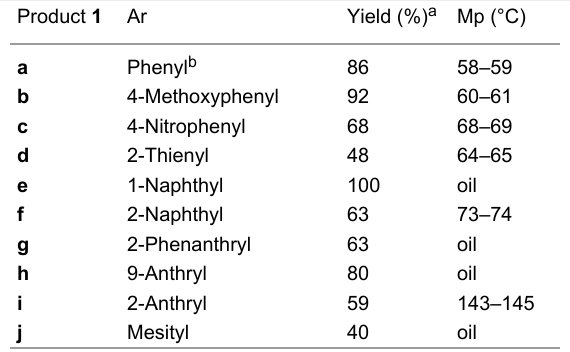
Table 1: Preparation of α-sulfonylallylic donor precursors 1 according to Scheme 2.